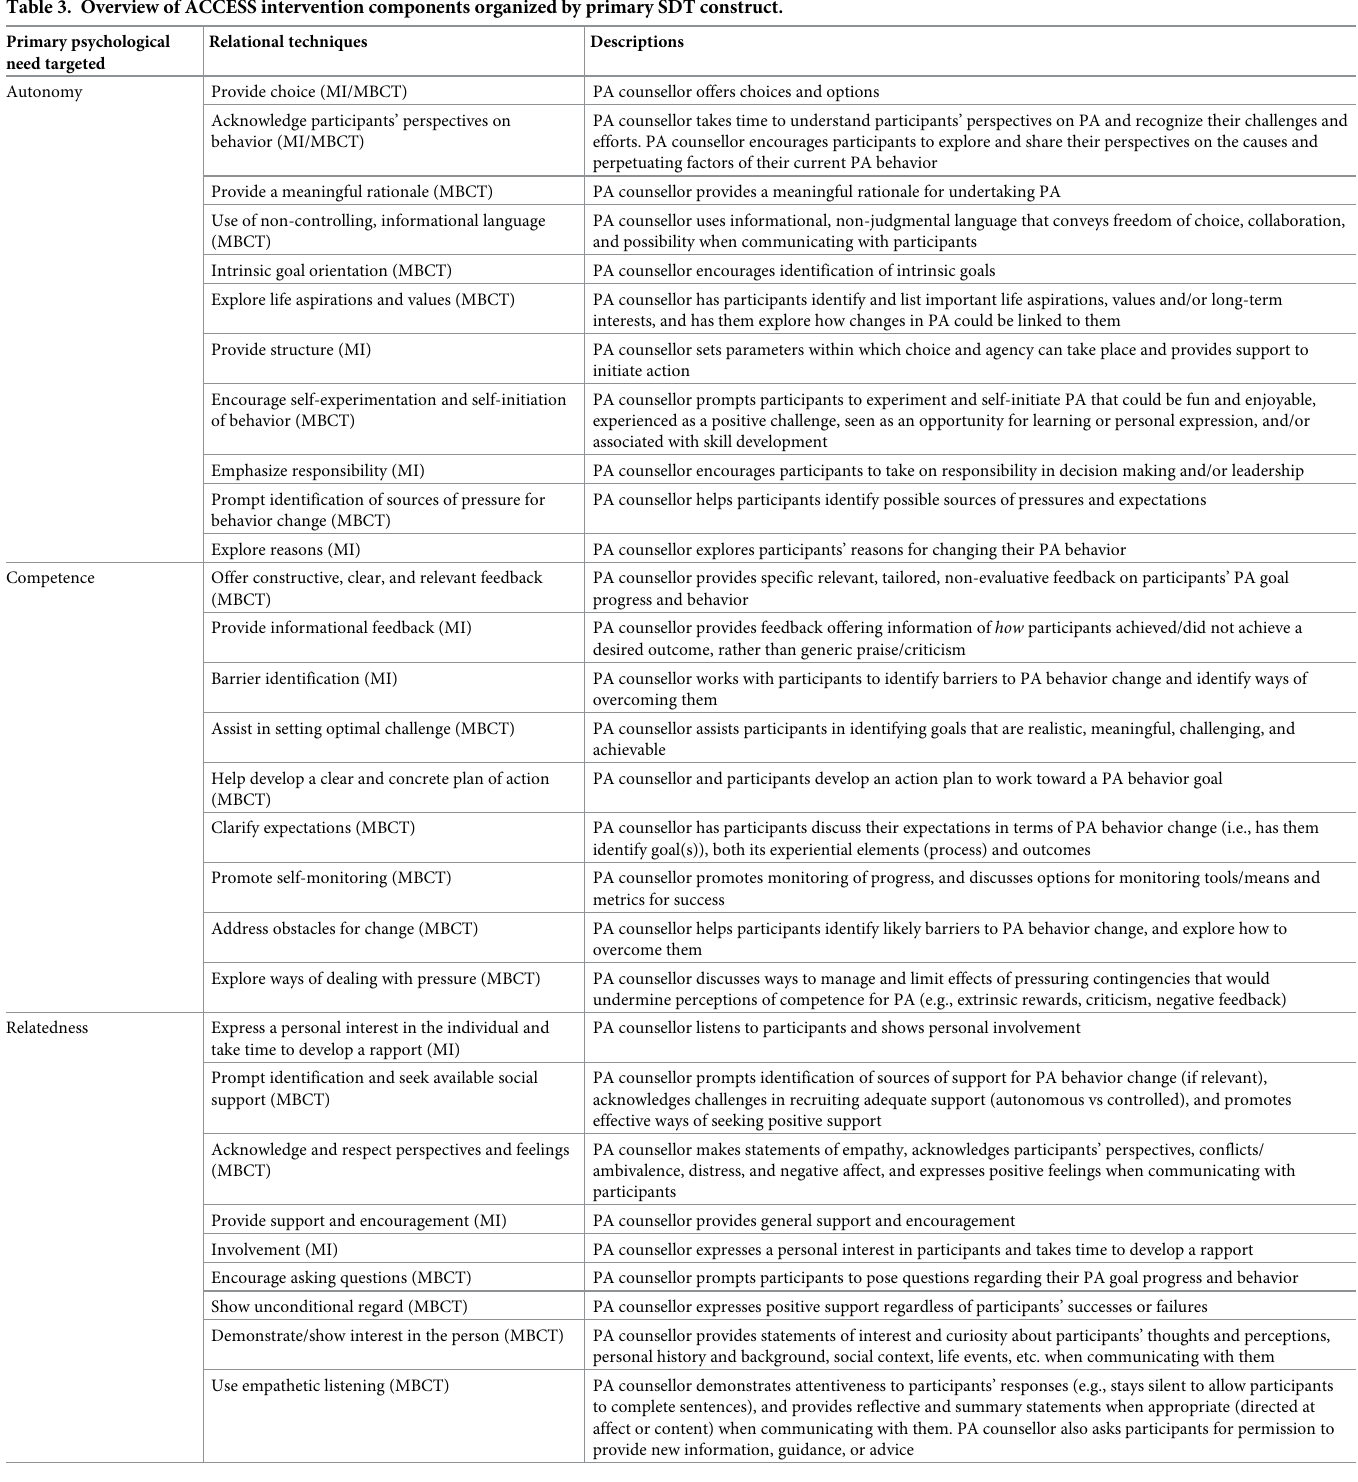
Table 3. Overview of ACCESS intervention components organized by primary SDT construct. Primary psychological need